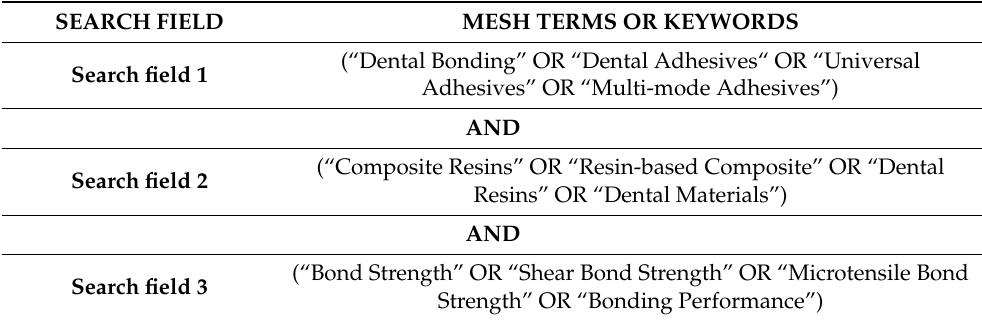
Table 1. Search strategy used in each electronic database. SEARCH